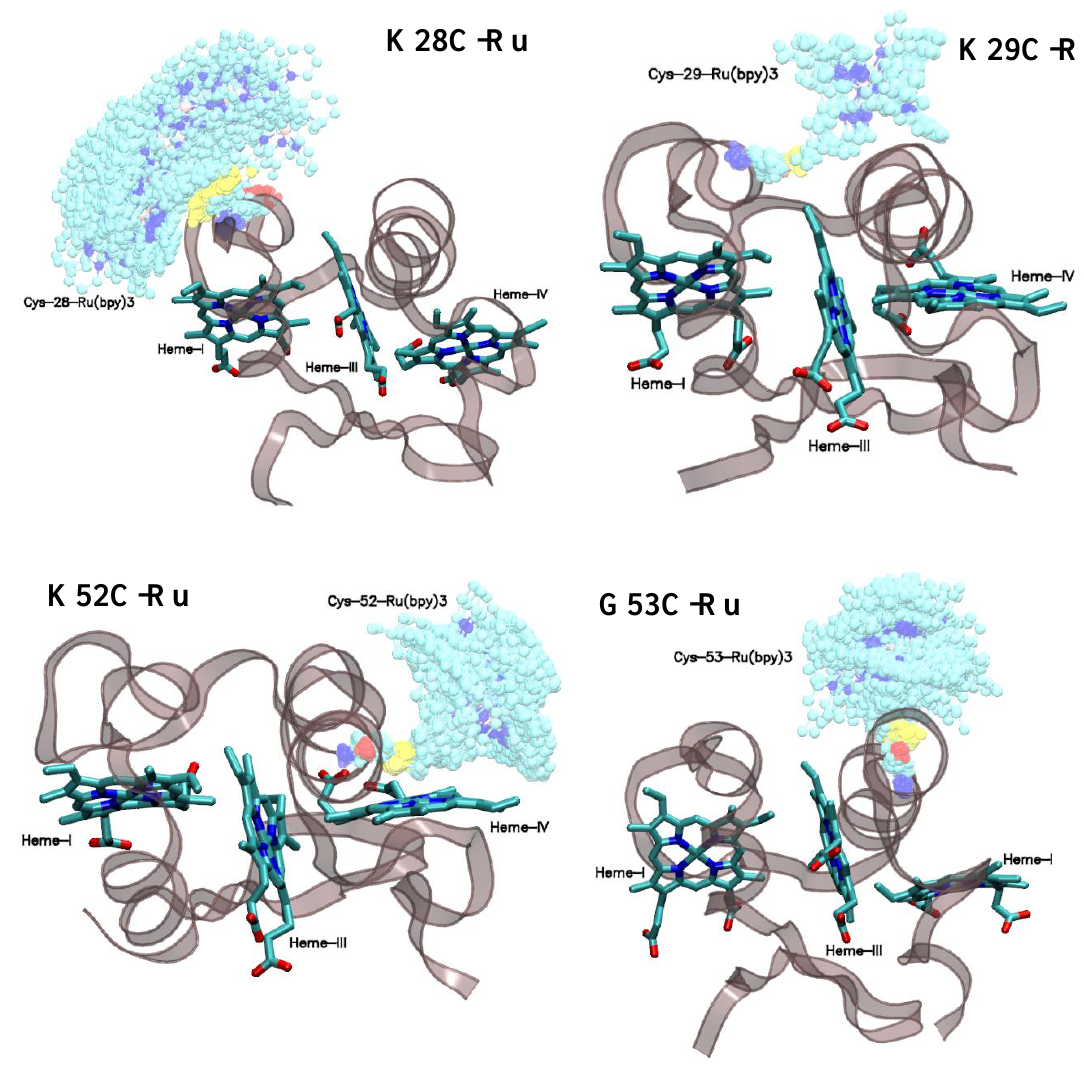
Figure 6. Figure 6. PpcA structures with overlaid photosensitizer structures from ~3ns separated in time MD snapshots.